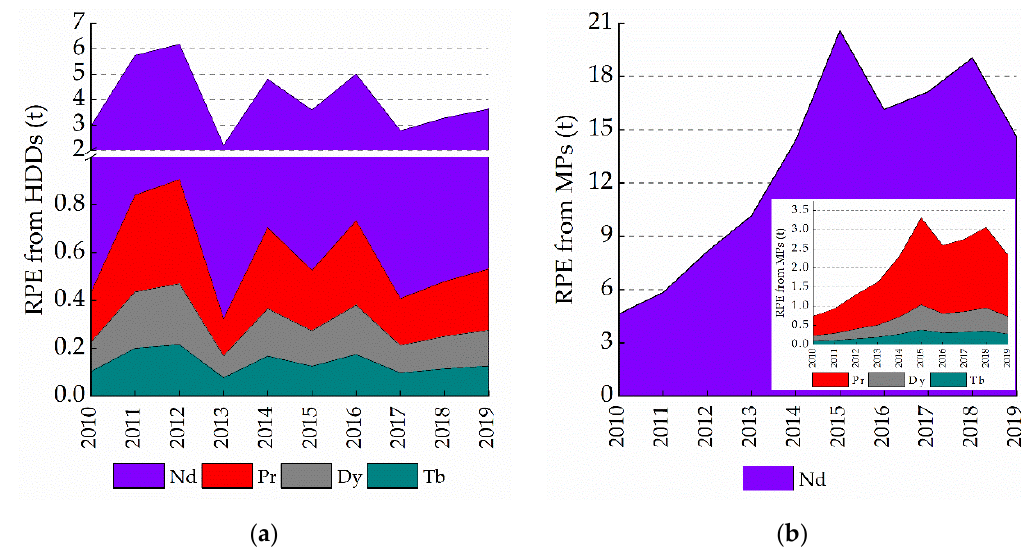
Figure 4. Recycling potential estimate of REEs from ( a ) hard disk drives and ( b ) mobile phones in the period of 2010–2019. Table 1. RPE (in t) from HDDs and MPs for each REEs and the sum within the period of 2010–2019.